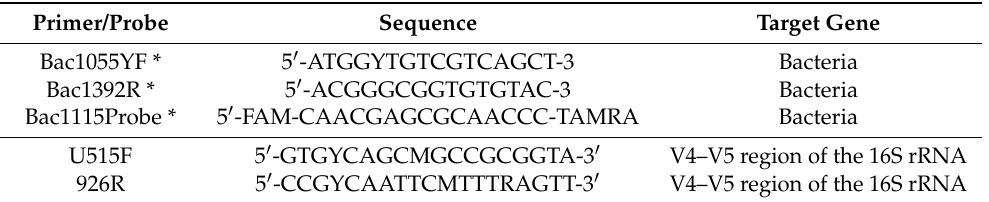
Table 3. The PCR primers and probe used to quantify and amplify total bacterial 16S rRNA genes. Primer/Probe